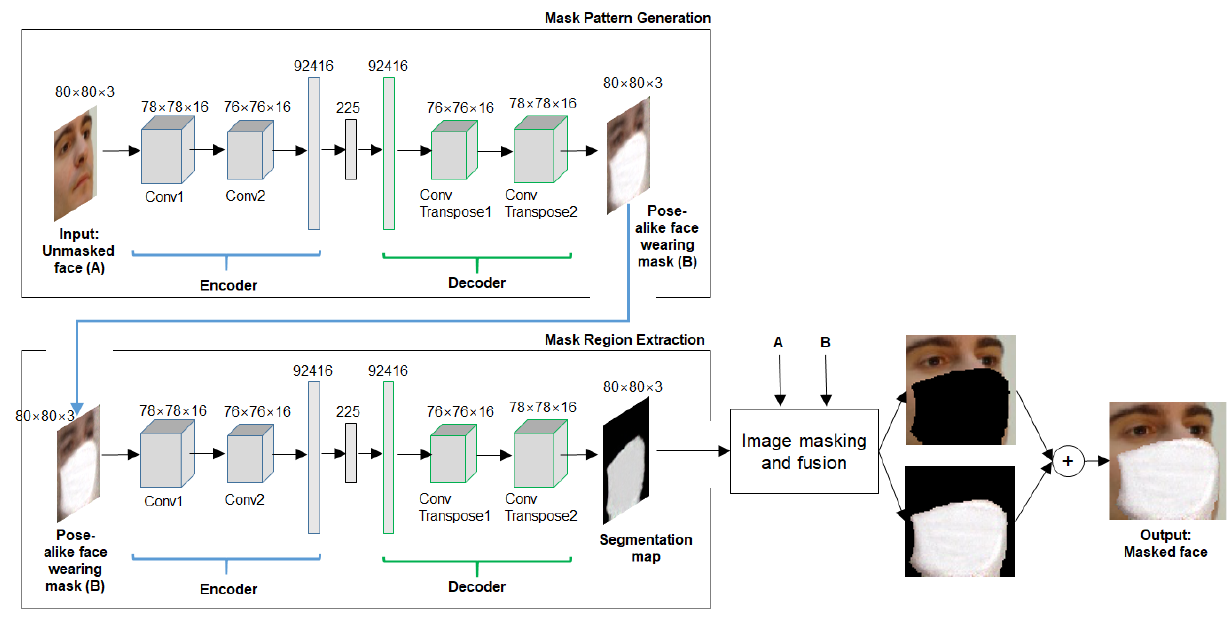
Figure 1. An overall framework of the proposed method. In this figure, an RGB face image of 80 × 80 pixels is used for input as an example. The stage of mask pattern generation aims to produce pose-alike face with a mask pattern reflecting the pose view of an input unmasked face. The stage of mask region extraction focuses on localizing the mask pattern by producing the segmentation map. In the stage of image masking and fusion, the mask pattern was fused with the input unmasked face, resulting in a realistic masked face.